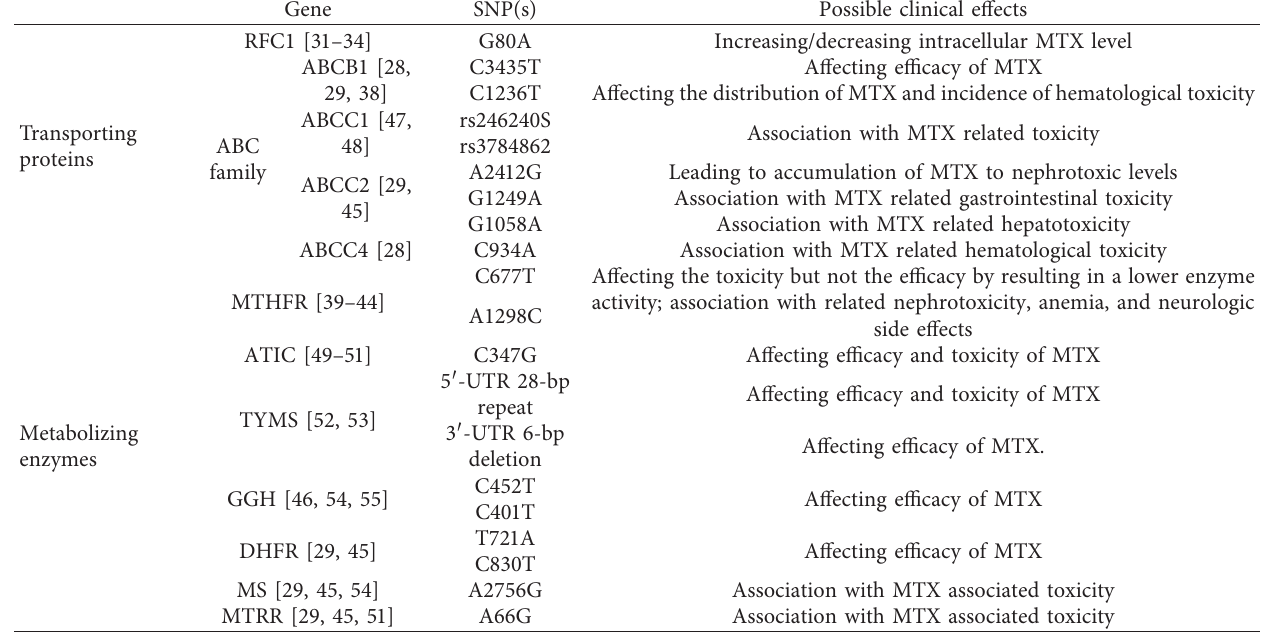
Table 1: Summary of genes and their SNPs which might have possible clinical effects towards